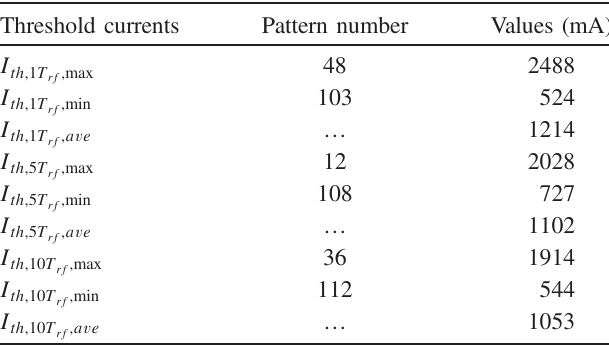
TABLE II. Maximum, minimum, and average I th for 1 T rf , 5 T 10 T rf , and rf bunch spacings when